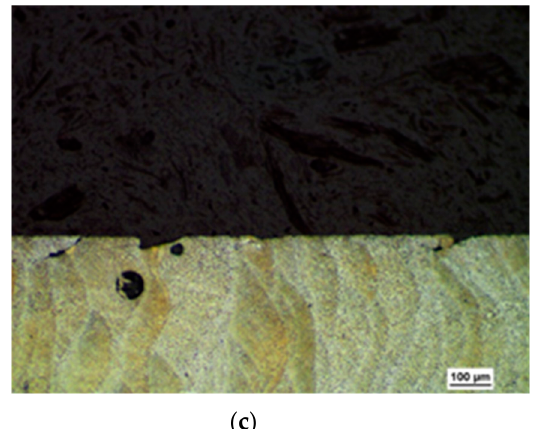
Figure 5. Surface morphology of the vibro-finished (VF) specimens. ( a , b ) SEM views of the top surface; ( c ) optical micrograph of a cross-sectioned sample showing a view of the surface profile.